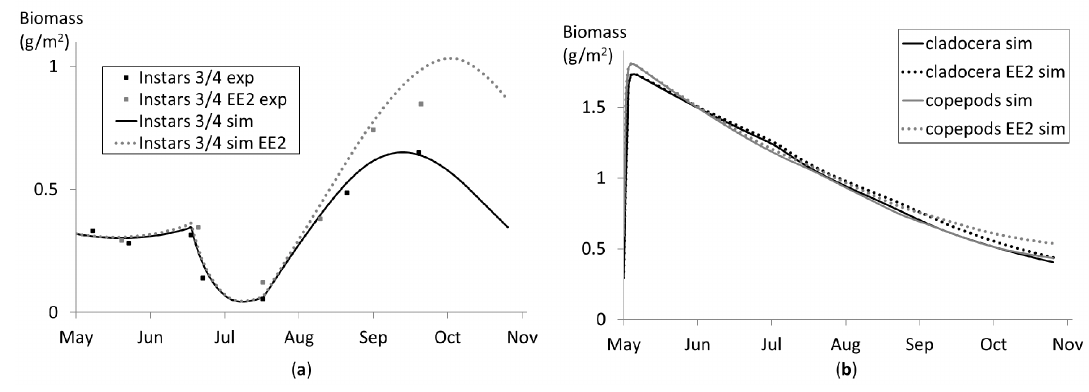
Figure 18. Simulation results with and without EE2 in the lake for ( a ) instars 3 and 4 of Chaoborus and ( b ) zooplankton (Cladocera and copepods; abbreviations: exp = experimental data; sim = simulation results).